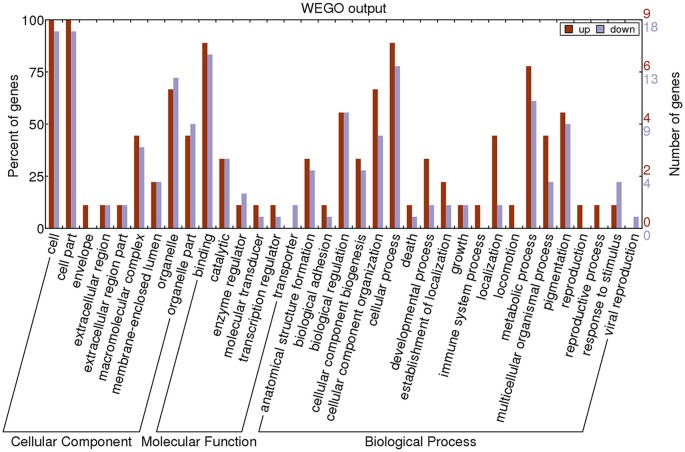
Gene Ontology (GO) classification of differentially expressed proteins by label-free Quantitative Proteomics experiments between MPP and controls. The differentially expressed proteins are grouped into three hierarchically structured GO terms: biological process, cellular component, and molecular function. The y-axis indicates the number and percent of proteins in each GO term.